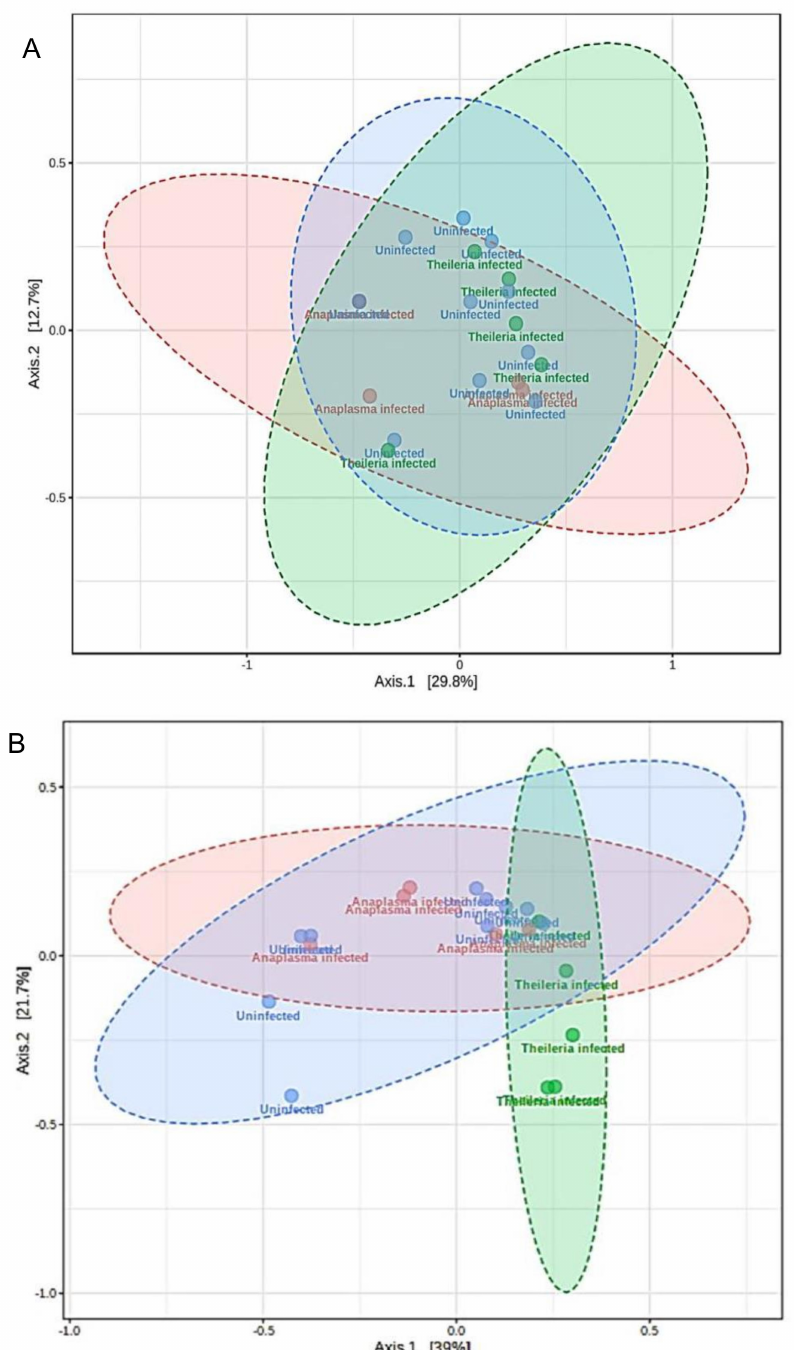
Figure 4. Estimation of di ff erences in the microbial communities as a measure of Beta diversity analysis in R. microplus ticks. ( A ) Principal coordinate analysis (PCoA) of the Bray–Curtis distance matrix (PERMANOVA, F-value: 4.2171; R: 0.33161; p -value < 0.005). ( B ) Principal coordinate analysis (PCoA) Jaccard distance matrix (PERMANOVA, F-value: 3.2588; R: 0.27714; p -value <